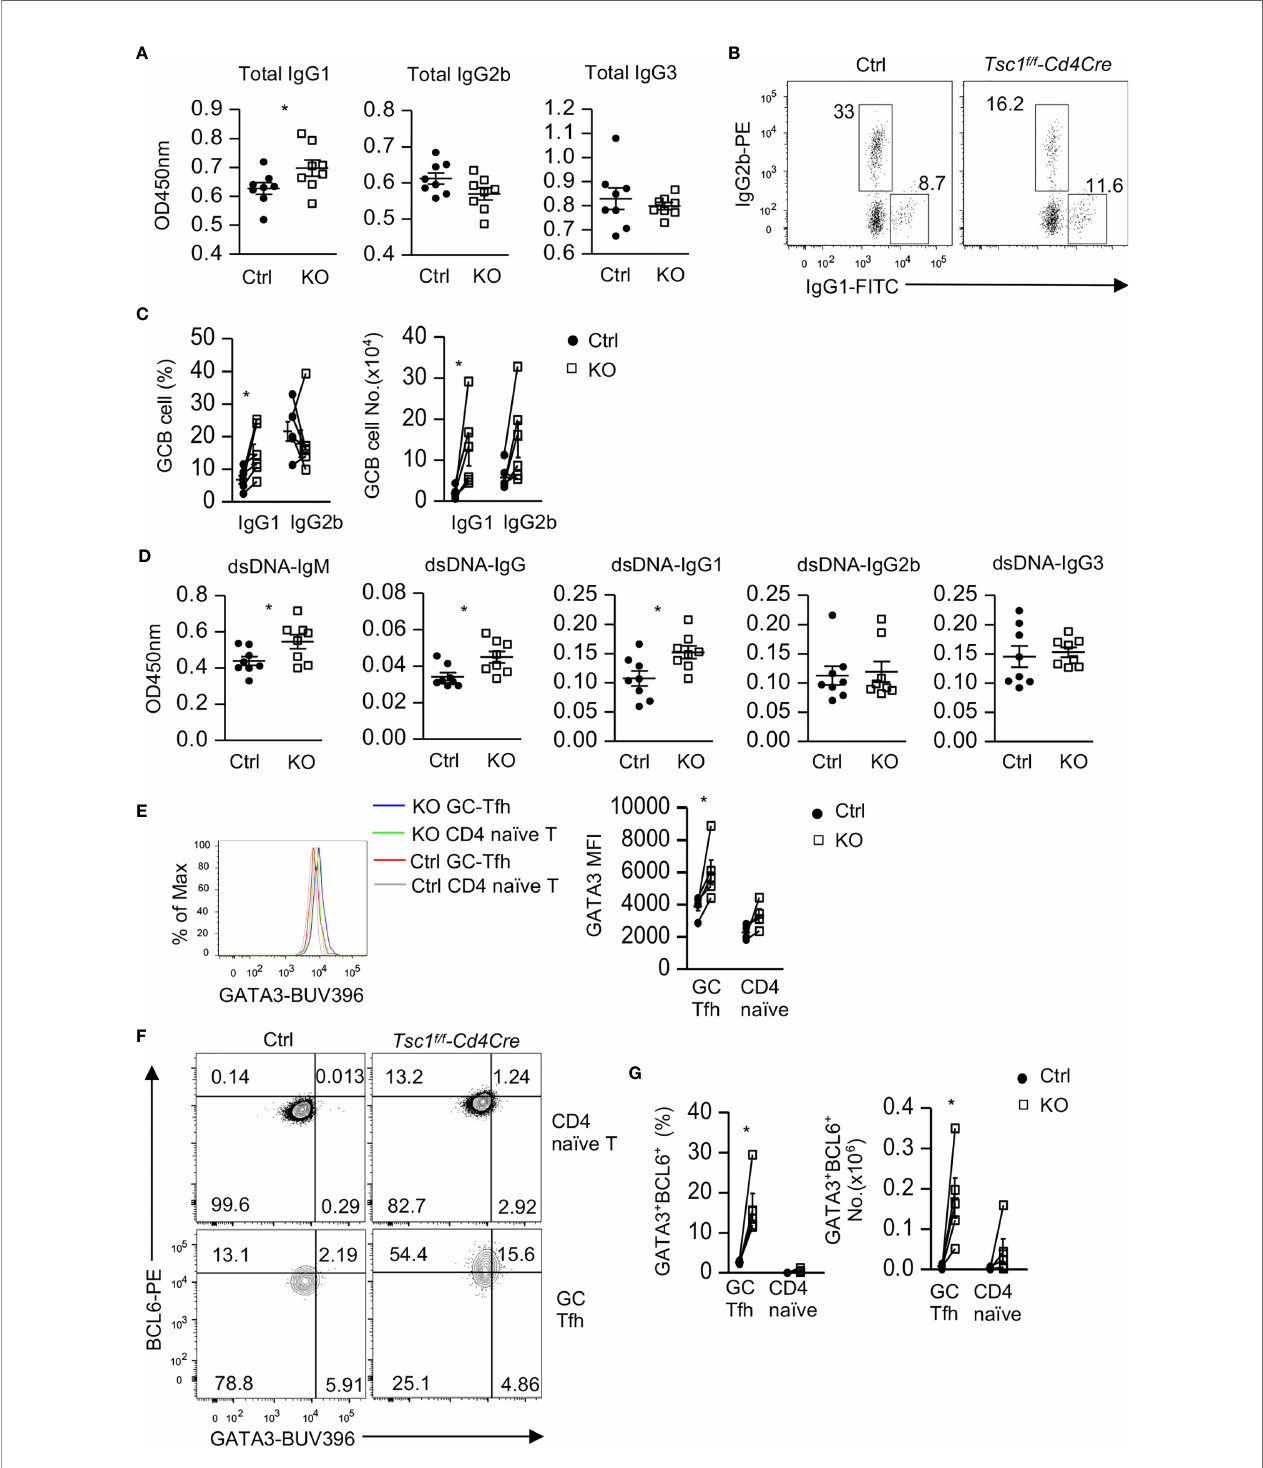
FIGURE 4 | Elevated IgG1 humoral immunity and Tfh2 cells in Tsc1-de fi cient mice. (A) Serum concentrations of IgG subtypes. (B) IgG1 and IgG2b expression in GC-B cells from spleen. (C) Scatterplots show mean ± SEM of percentages and numbers of IgG1 + and IgG2b + cells within GC B cells. (D) Serum autoantibodies levels detected by ELISA. (E) Overlaid histogram showed Gata3 levels in GC-Tfh and naïve CD4 + TCR b + Foxp3 - T cells. (F) Representative FACS plots show Gata3 and Bcl6 expression in GC-Tfh and naïve CD4 + TCR b + Foxp3 - T cells. (G) Scatterplots show percentages and numbers of Bcl6 hi Gata3 + Tfh2 cells within GC-Tfh and naïve CD4 + TCR b + Foxp3 - T cells. Data shown are representative of or pooled from 2 – 5 experiments. * p < 0.05 determined by an unpaired (A, D) and pairwise (C, E, G) two-tailed Student t